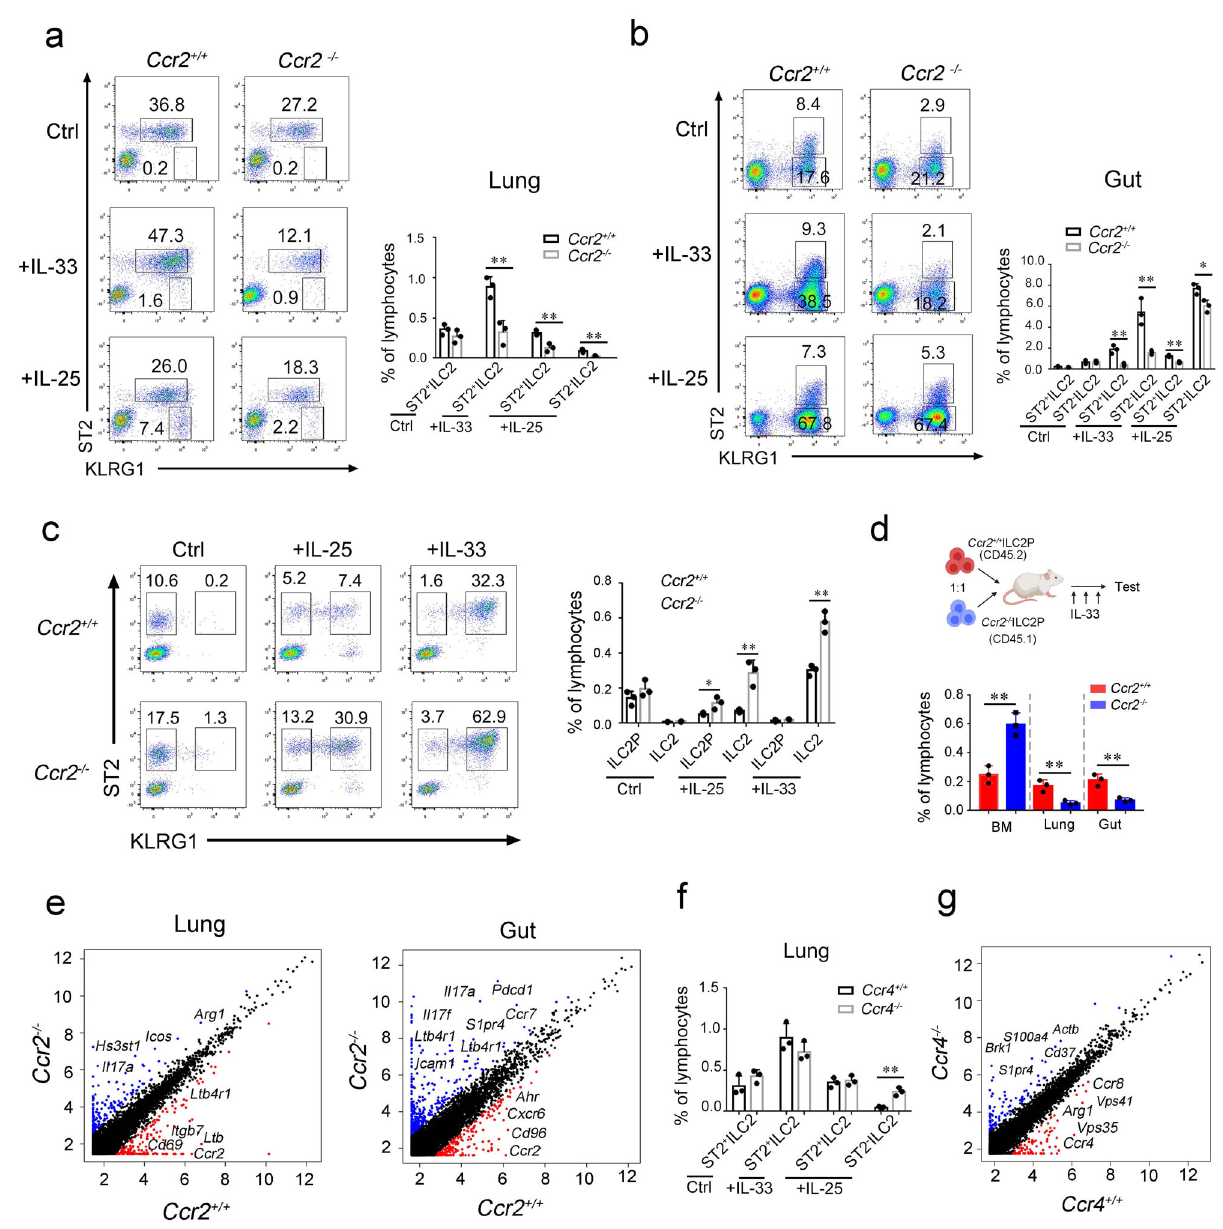
Fig. 5 | The differential function of CCR2 and CCR4 in lung and gut ILC2s. a , b De fi ciencyofCCR2abrogatedtheILC2countsinthelung( a )andgut( b ).WTor Ccr2 − / − mice were subjected to the i.p. injection of IL-25 or IL-33 followed by fl ow cytometryanalysis.ThecellfrequencyofindicatedILC2subsetswascalculatedand shown as mean±SD (right panel). ( n =3 for each group) ( P =0.0072, 0.0059, 0.0056 for a , P =0.0040, 0.0066, 0.0012,0.0196 for b ). c CCR2 isrequired forthe ILC2 relocalization from BM to the lung. ILC2Ps (Lin − CD127 + Sca1 + ST2 + KLRG1 − ) and ILC2s (Lin − CD127 + Sca1 + ST2 + KLRG1 + ) from BM of WT or Ccr2 − / − mice were analyzed by fl ow cytometry. The indicated ILC2 subsets was calculated and shown as mean±SD (right panel). ( n =3 for each group) ( P =0.0376, 0.0064, 0.0021). d Adoptive transfer of WT and Ccr2 − / − ILC2Ps. ILC2Ps (Lin - CD127 + Sca1 + ST2 + KLRG1 − ) wereisolatedfromBMofWTand Ccr2 − / − mice.WTand Ccr2 − / − ILC2Pswere1:1mixed (5×10 4 for each) and i.v. injected into B-NDG mice. One week after transfer, the recipient mice were i.p. injected with 400ng/mouse/day IL-33 for three days. The cellfrequencyofILC2sinthelungandgutwerecalculatedandshownasmean±SD. ( n =3 for each group). ( P =0.0039, 0.0086, 0.0050 by Two-tailed unpaired